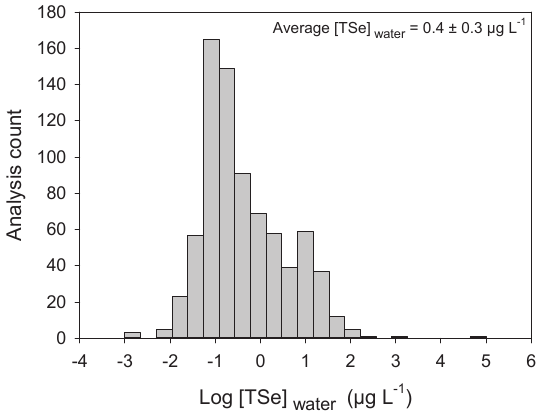
Figure 3. Frequency distribution of log-transformed total dissolved Se concentrations (Log [TSe] water ; µ g L − 1 ) in water from around the world ( n = 775). Average and standard error is presented in the graph.